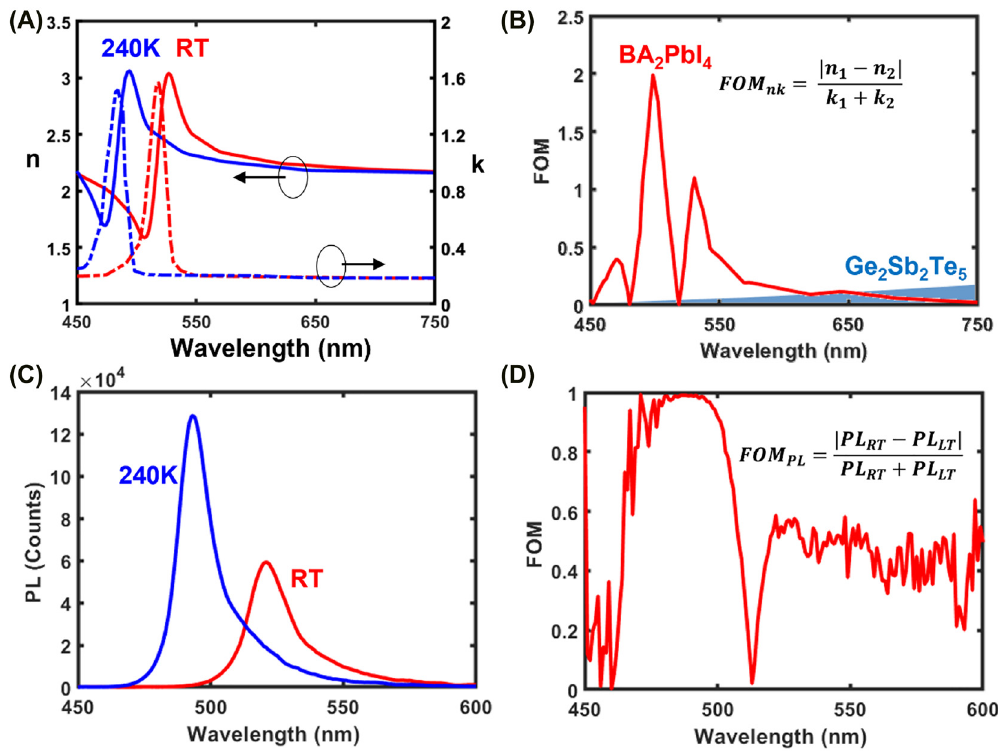
PbI . 2 4 PbI at 293 K (red curves) and 240 K (blue curves). 2 4 ) of BA PbI and Ge Sb Te in the visible spectrum. PC 2 4 2 2 5